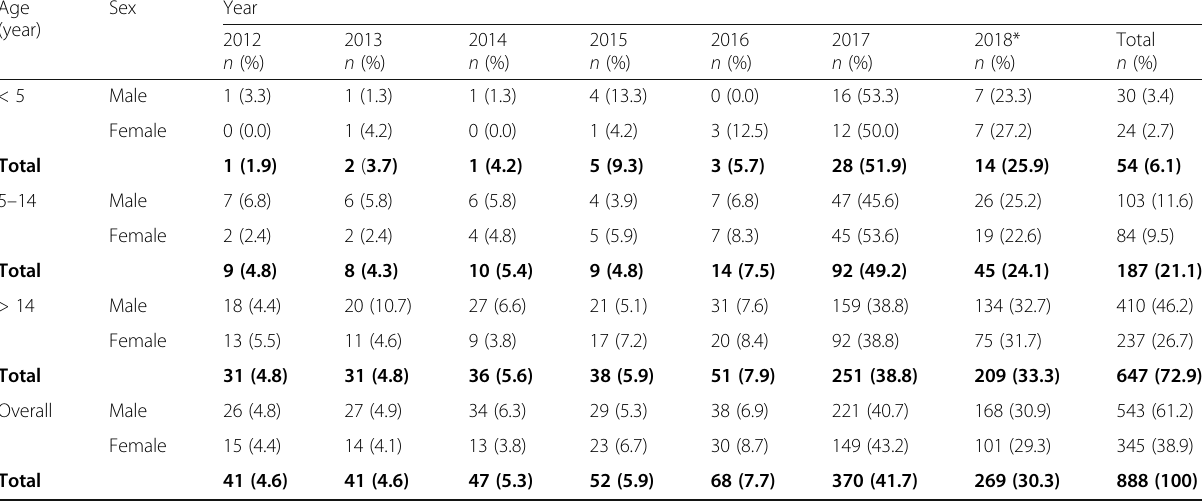
Table 2 CL in different age and sex groups among patients who visited the BMH Dermatology Department between 2012 and May 2018 ( N = 888)